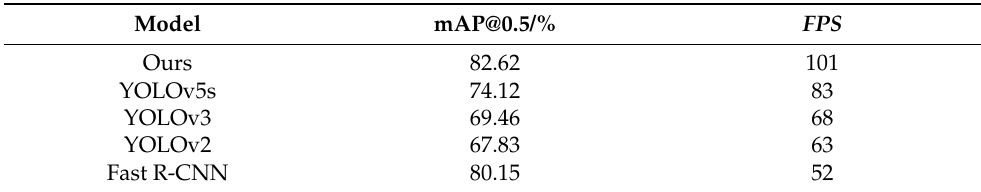
Table 3. Comparison of mainstream models.